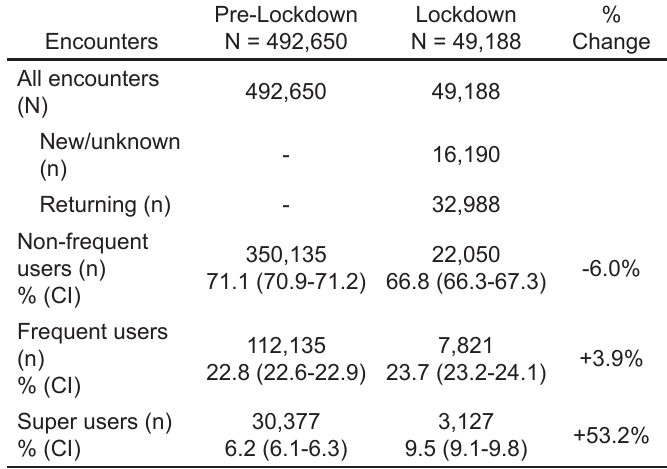
Table 4. Proportion of total encounters by patient